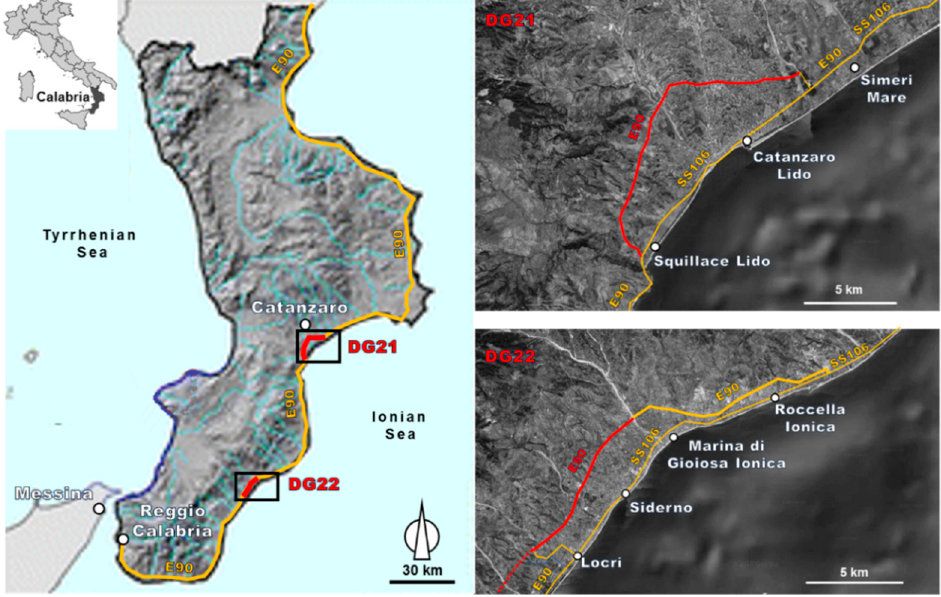
Figure 1. Map of the Calabria Region, Southern Italy, with DG21 and DG22 maxi lots.